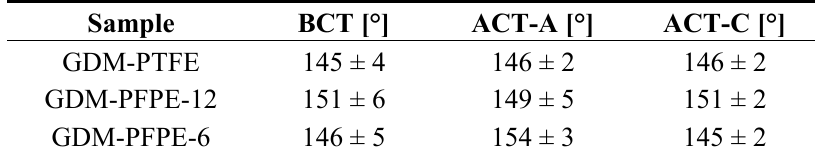
Table 2. Static contact angles detected before and after cell testing Sample